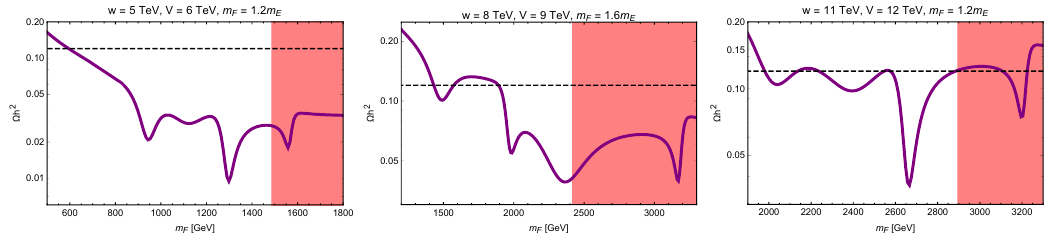
Figure 5 . The total relic density of two-component fermion dark matter as a function of dark matter masses for the case m F > m E .